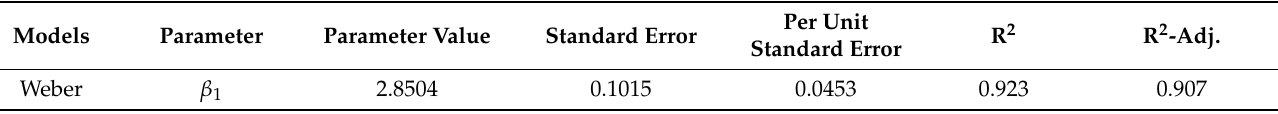
Table 1. The modified Weber model